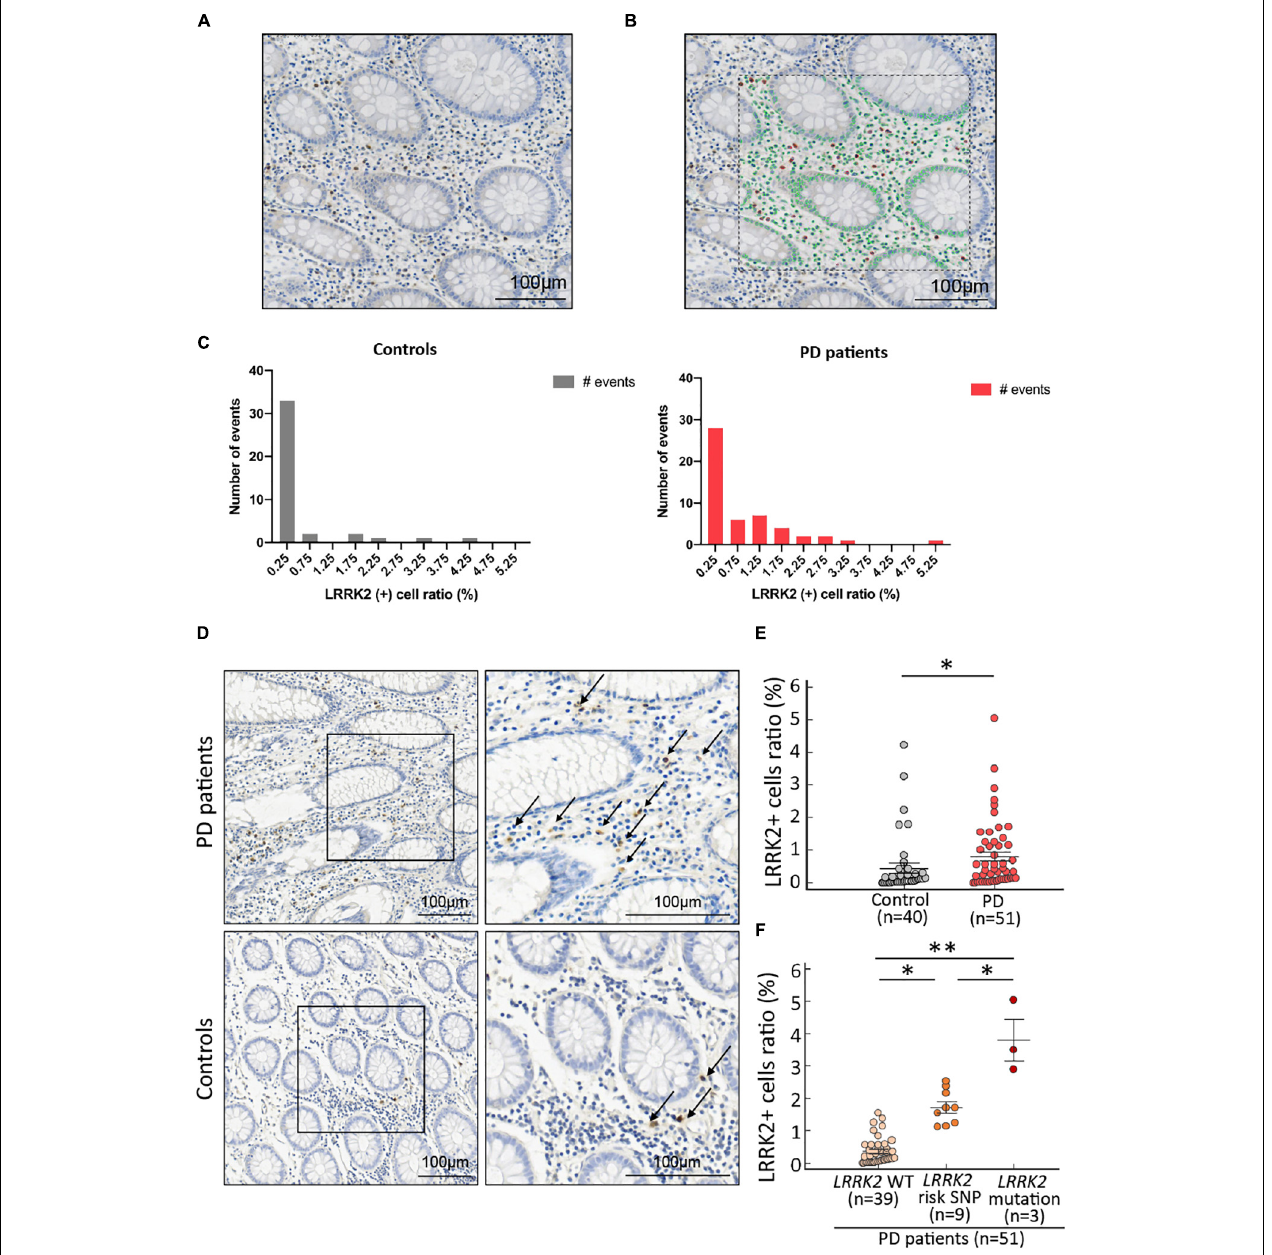
FIGURE 1 | LRRK2 expression in colonic biopsies from PD patients and age- and gender-matched controls. (A) Original view of the represented colonic biopsy tissues. (B) All nuclei are circled with green lines, and the LRRK2-positive staining detected as positive events are circled in red lines (arrows) by the StrataQuest Analysis software version 6 (TissueGnostics, Vienna, Austria). (C) Distribution histograms of the LRRK2-positive ratio in PD patients and controls. (D) Representative pictures of LRRK2-positive cells in the submucosa of colonic samples from one 72-year-old male PD patient and one 71-year-old male control participant. Positive events are indicated by arrows. The pictures on the right are the magnification of the framed areas on the left. Scale bar: 100 µ m. (E) The fractions of LRRK2-positive cells in the total cell counts in colonic biopsies were significantly higher in PD patients than controls ( P = 0.004 by Mann-Whitney U -test). (F) The fractions of LRRK2-positive cells in the total cell counts in colonic biopsies from PD patients with wild type or genetic variant in LRRK2 . * P < 0.05; ** P < 0.01.